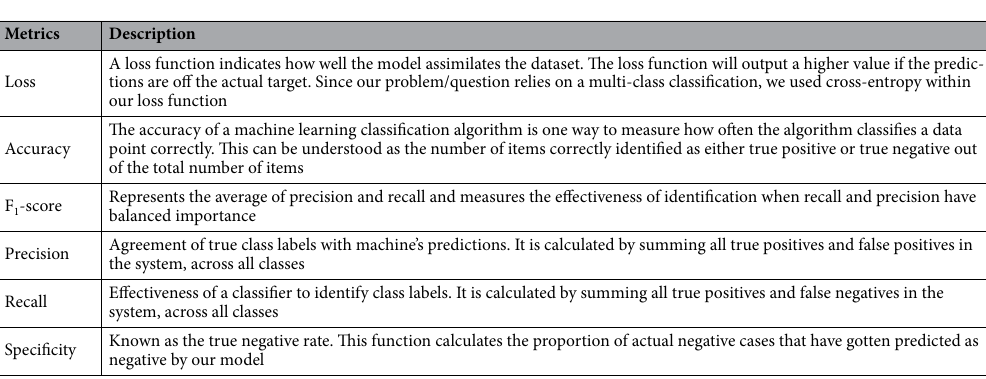
Table 4. Diagnostic metrics used to evaluate the performance of the investigated CNN architectures. CNN convolutional neural network.